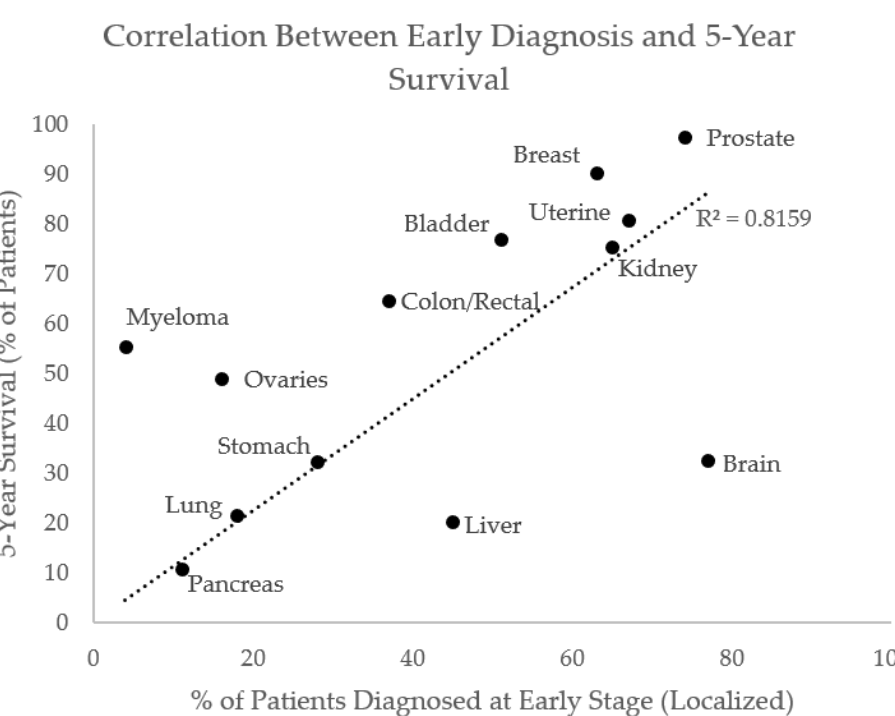
Figure 2. There is a strong correlation between early diagnosis and 5-year survival across cancer types. Data from: Surveillance, Epidemiology, and End Results (SEER) Program Populations (2011– 2017) (www.seer.cancer.gov/popdata) accessed on 2 February 2022, National Cancer Institute, DCCPS, Surveillance Research Program, released February 2021.